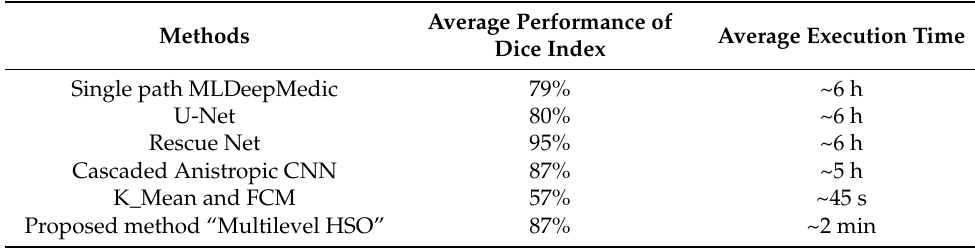
Figure 6. The figure represents the values of the metrics (Accuracy, Sensitivity, Precision, and Dice) index for 10 images according to the segmentation “Multi-level HSO threshold”. Table 1. Performance comparison between our proposed method and different approaches on the BraTS dataset [32].